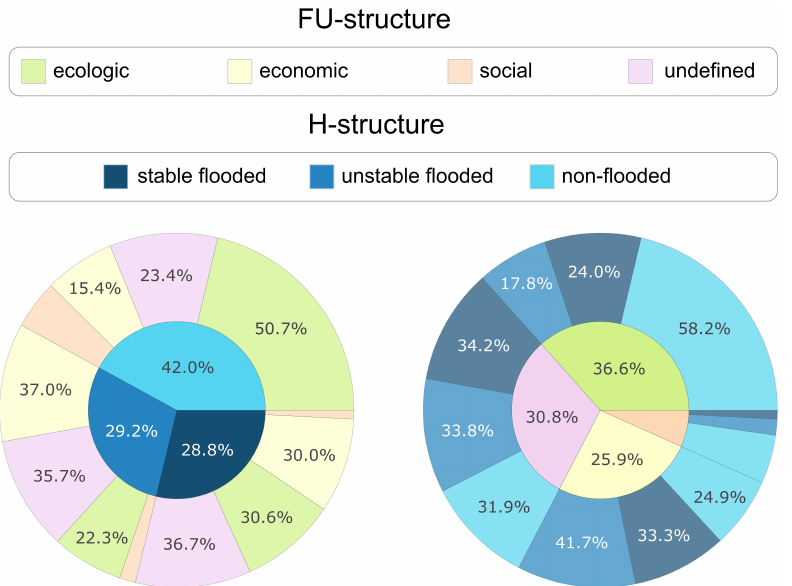
Figure 13. Relative total areas of 12 types of modern territorial HFN -structure for the northern part of the VAF.